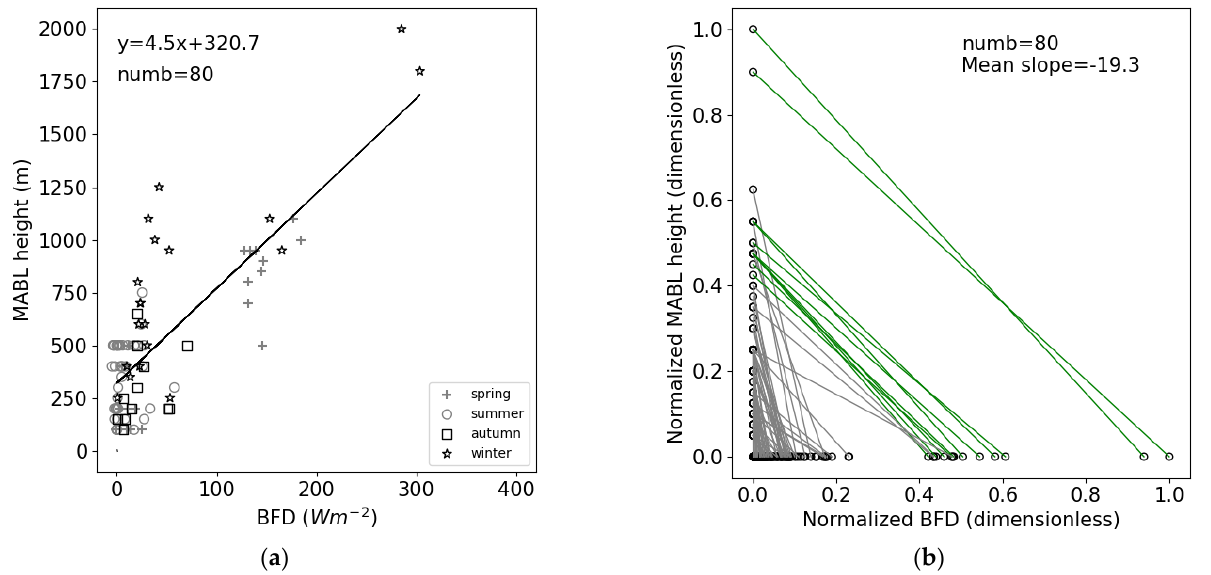
Figure 10. Development of MABL heights depending on the ( a ) BFD, and ( b ) the relationship be- tween the normalized MABL height and the normalized